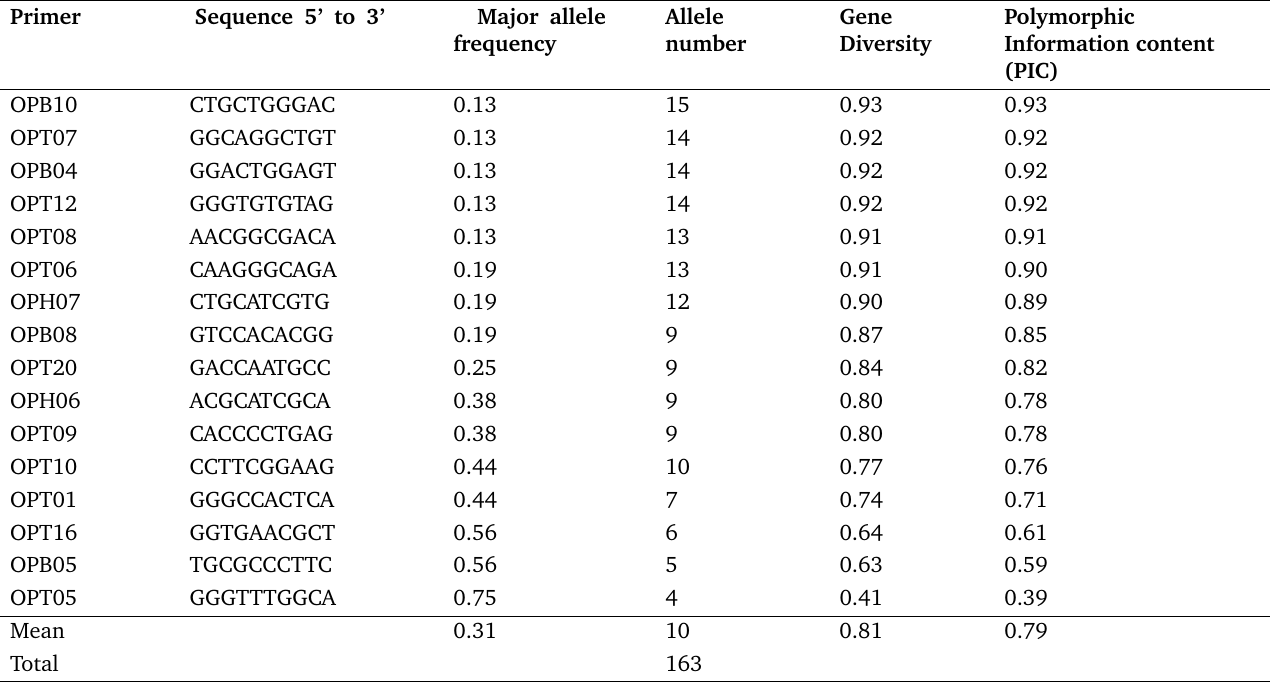
Table 2. List of primers used and RAPD polymorphisms among Parkia biglobosa accessions. Allele Primer Sequence 5’ to 3’ Major allele Diversity frequency